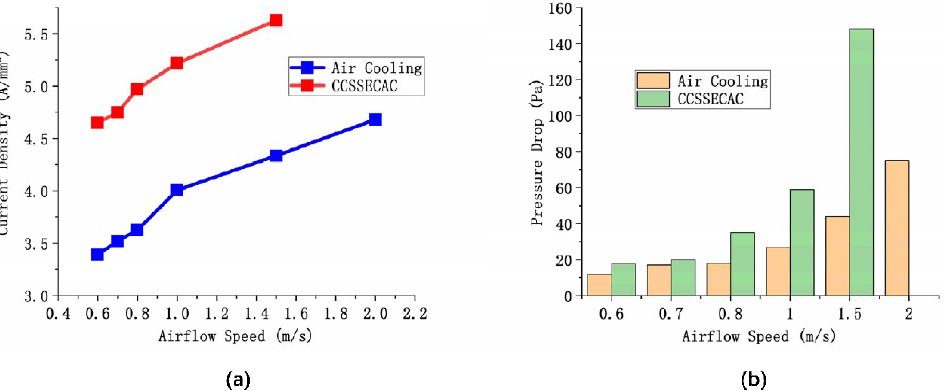
Figure 9. Comparison at a temperature rise of 50 °C: ( a ) current density at different airflow speeds and ( b ) airflow friction loss at different airflow speeds.